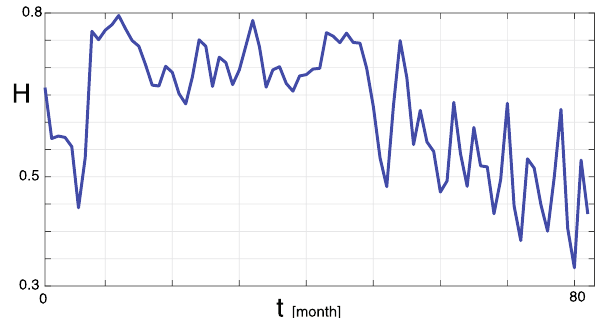
Figure 8. Evolution of the Hurst exponent H of the logarithmic Android market share changes (rolling